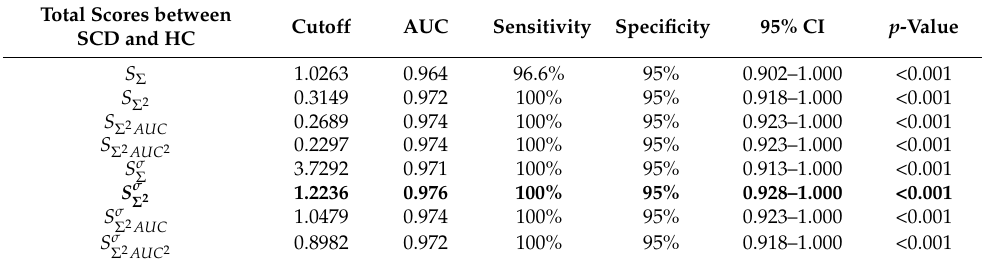
Table 6. Diagnostic score classification between SCD and HC.